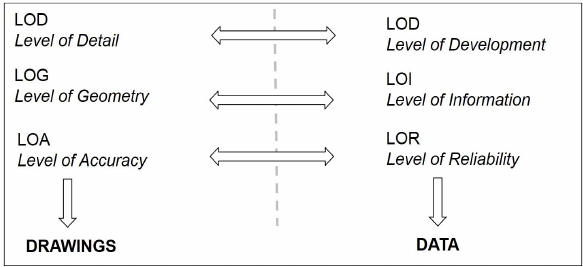
Figure 2. Different acronyms mentioned and defined in national and international